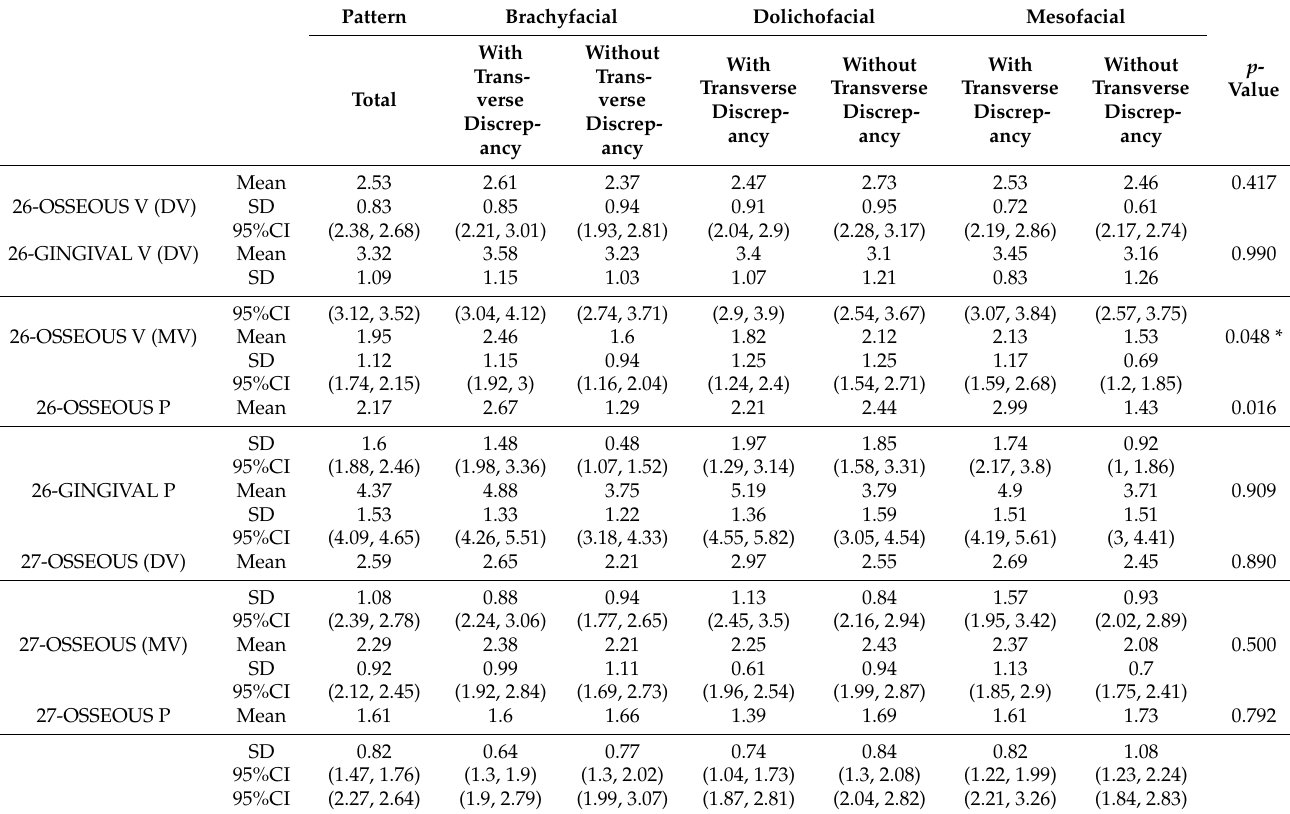
Table 7. Linear measurements corresponding to upper left molars in the different vertical facial patterns, in the presence and absence of transverse bone discrepancy. Pattern Brachyfacial Dolichofacial Mesofacial